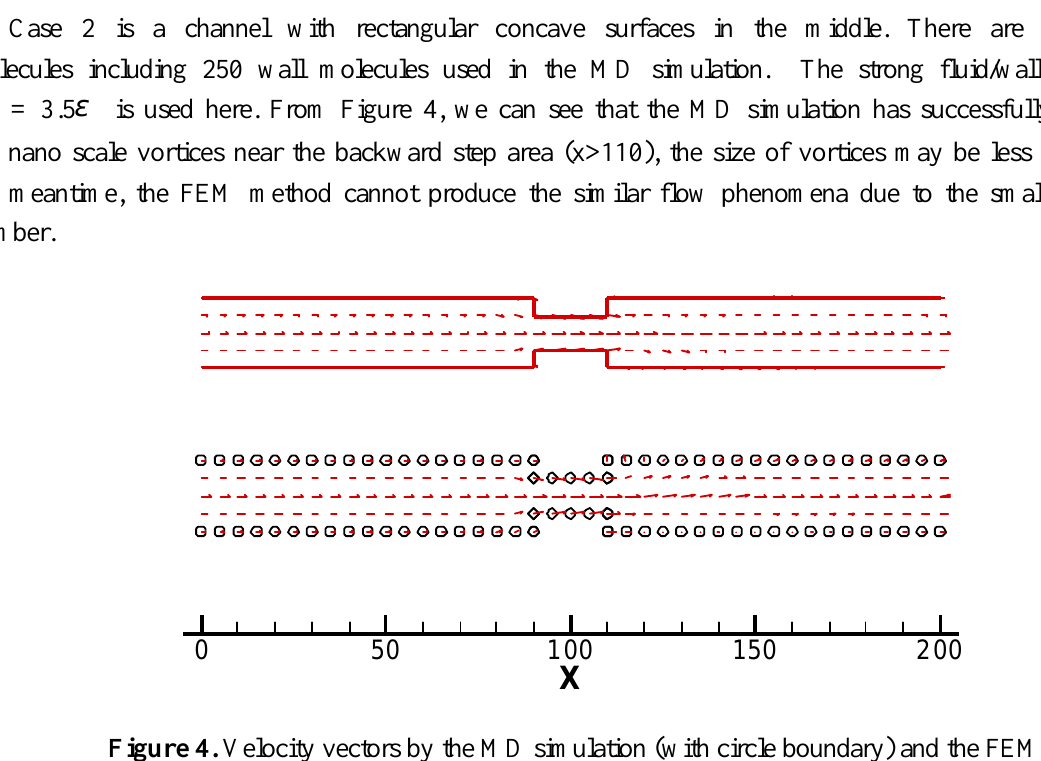
Figure 4. Velocity vectors by the MD simulation (with circle boundary) and the FEM (with solid line boundary) in Case